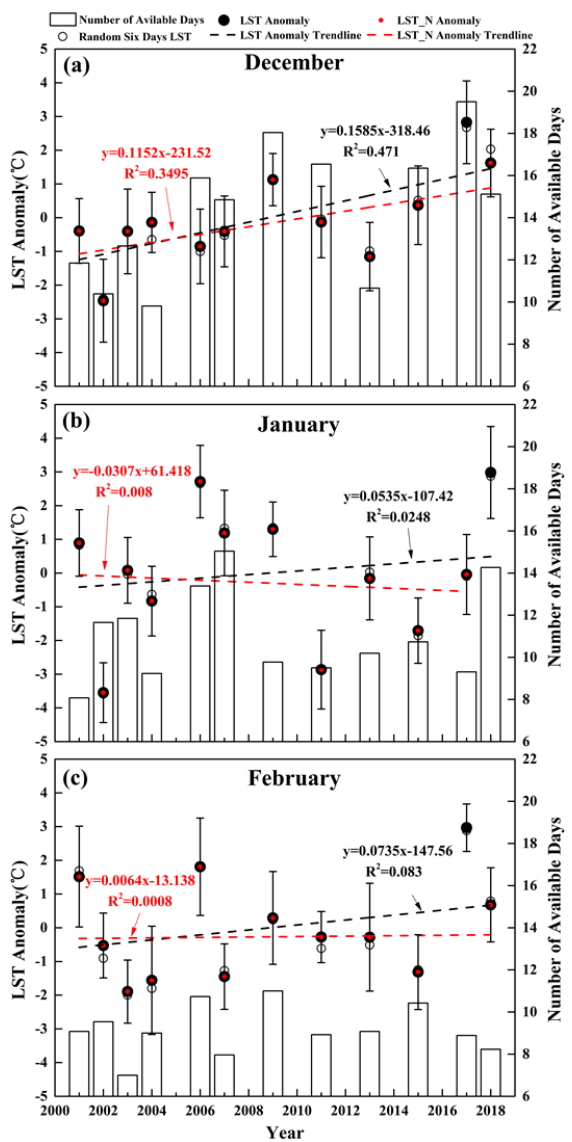
Figure 6. Variations in LST (land surface temperature) anomalies (dots) and their linear trend (dashed lines) in ( a ) December, ( b ) January, and ( c ) February over the Purog Kangri ice field. The monthly mean LSTs of all available days during the entire study period are shown in black dots, while those excluding the year with the maximum value are shown in red dots. The histogram indicates the number of days used to calculate the monthly average LST for each month, and the mean LST anomalies calculated from 6 randomly selected days in the month are shown by gray circles.